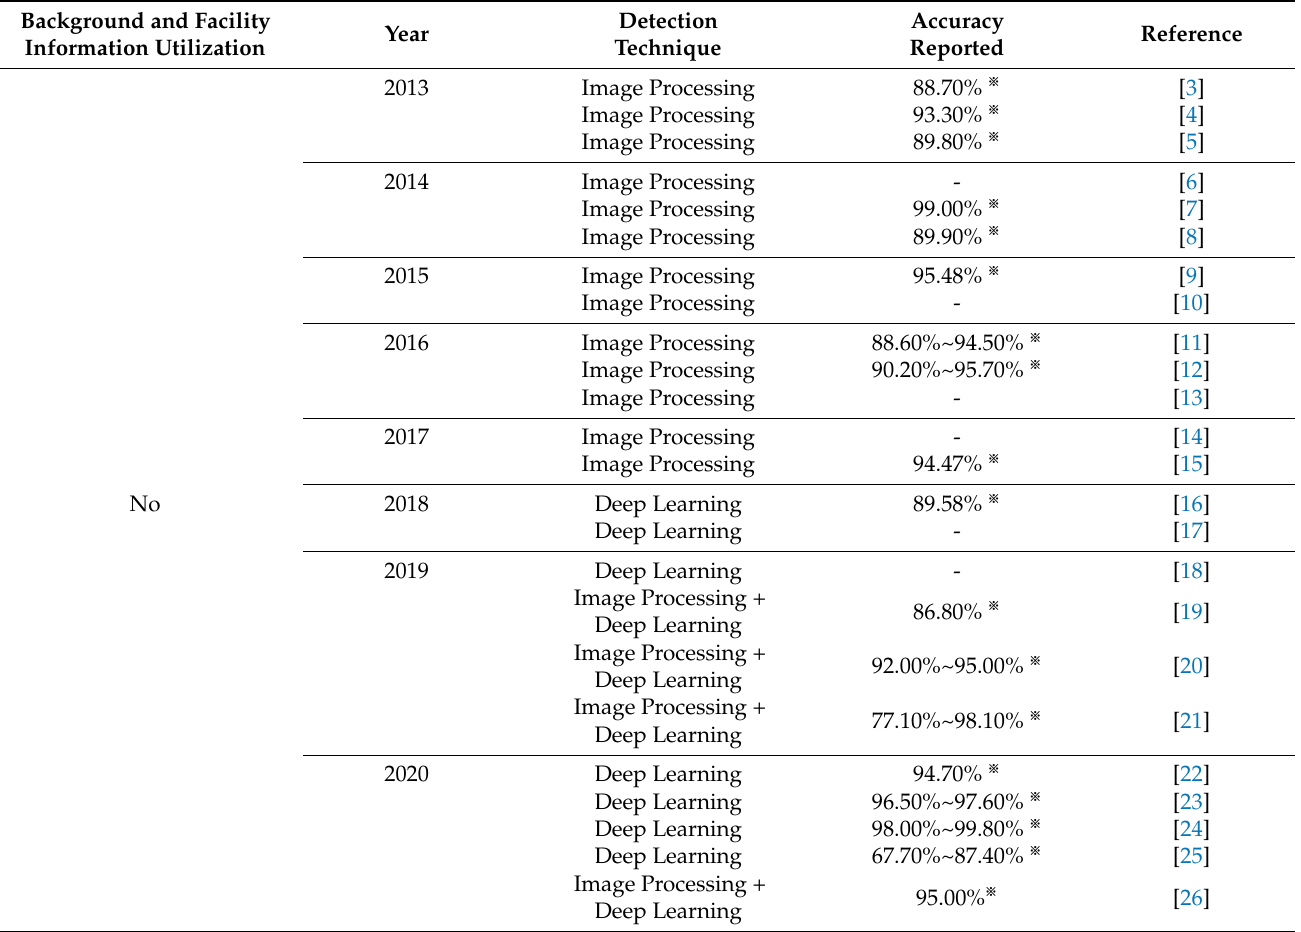
Table 1. Some of the recent results for group-housed pig detection (published during